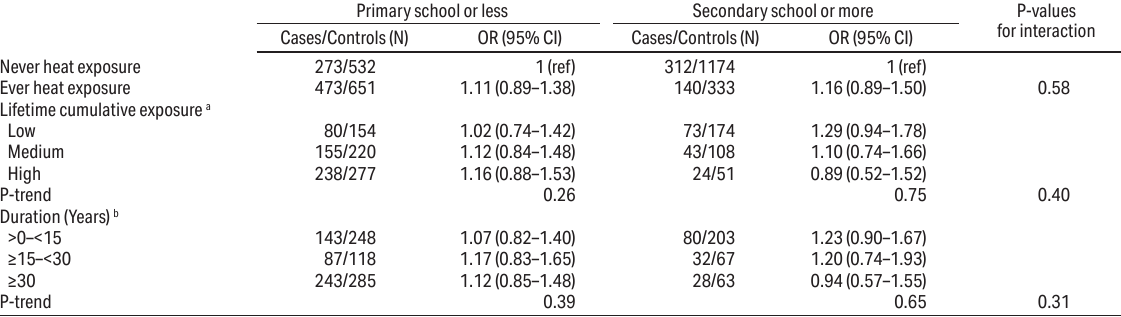
Table 5. Associations between occupational heat exposure and colorectal cancer stratified by education. [OR=odds ratio; CI=confidence interval]. All models are adjusted for age, sex, region, education, family history of colorectal cancer, BMI and occupational physical activity. Primary school or